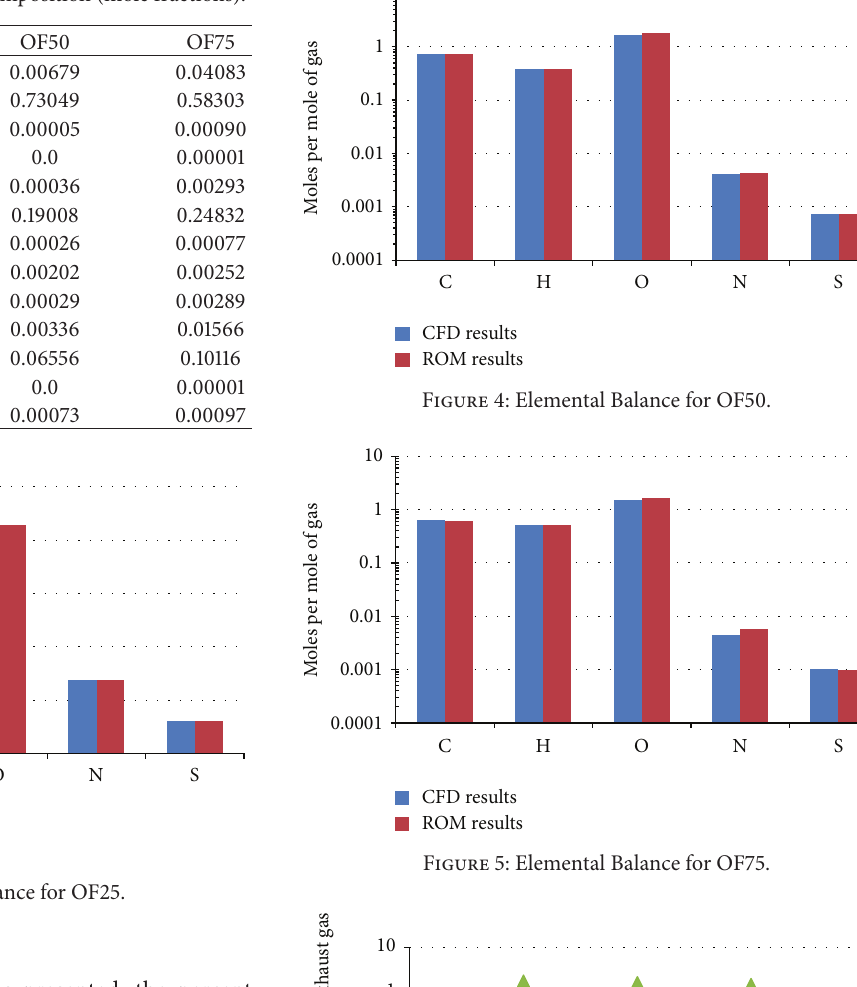
Table 6: ROM-predicted outlet gas composition (mole fractions).